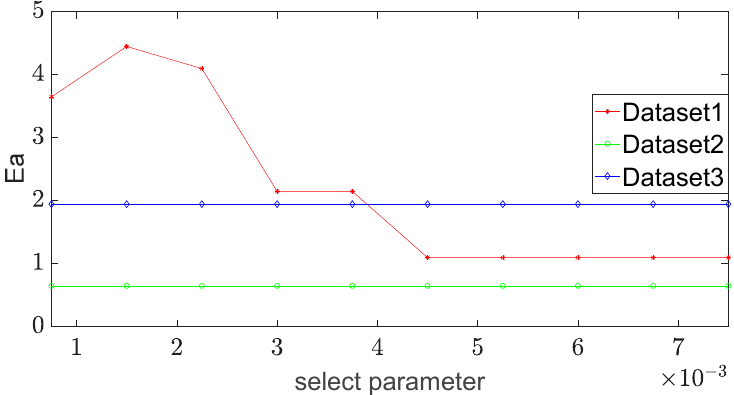
Figure 7. The error of the long axis vs. select parameter in different datasets.